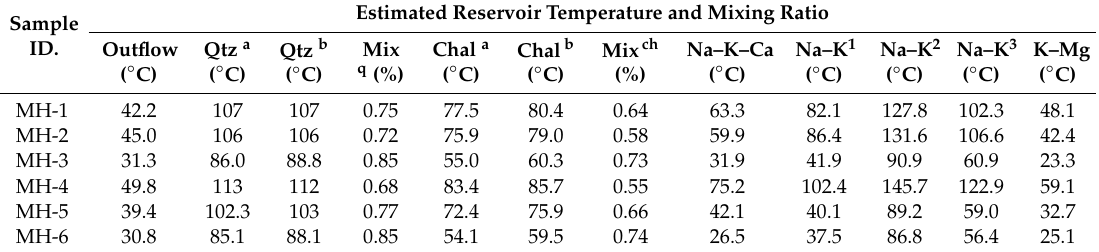
Table 5. Estimated reservoir temperatures and mixing ratios of thermal waters using quartz, chalcedony, and cation